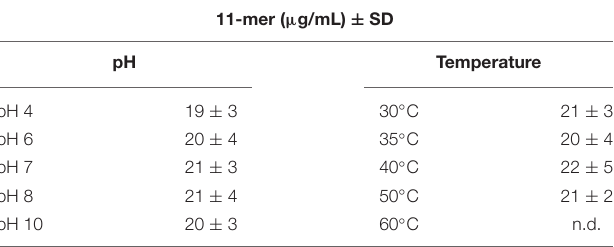
TABLE 5 | Effect of pH and temperature in 11-mer production by using protease-extract as enzyme and β -casein as substrate.